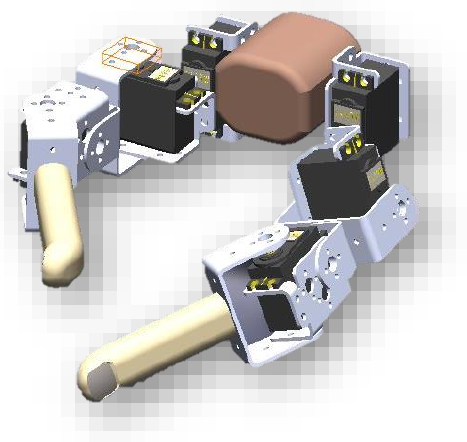
Figure 1. 3D SolidWorks design of extra robotic fingers.